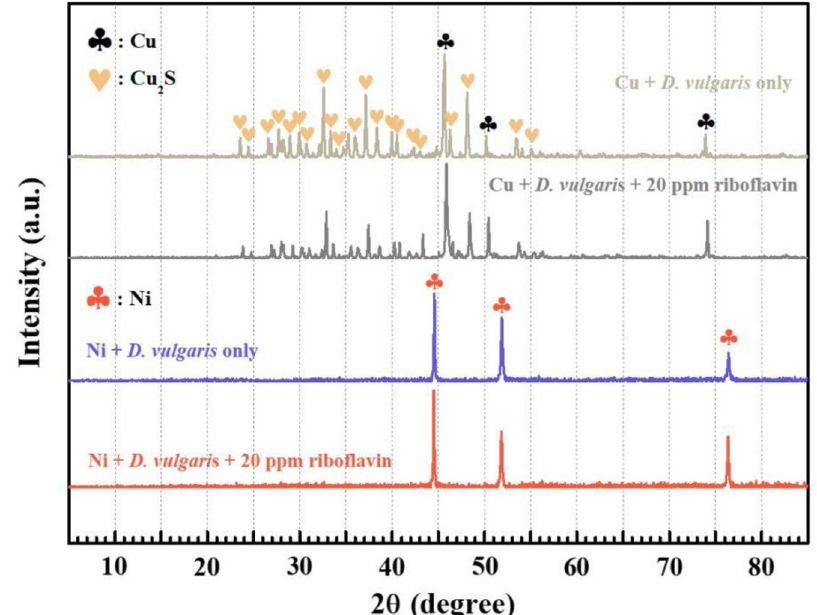
Fig. 4 XRD. XRD patterns of the corrosion products on Cu and Ni coupons after the 7-d incubation in the D. vulgari s media without and with ribo fl